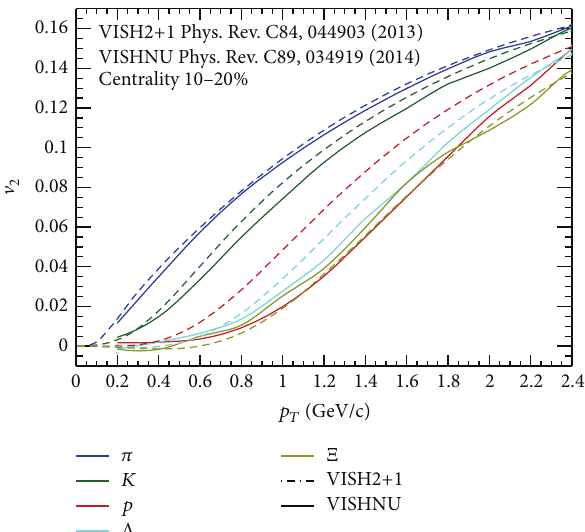
Figure 7: The viscous hydrodynamical calculations without a had- ronic cascade afterburner (VISH2+1) and with a hadronic cascade afterburner (VISHNU) [25, 37, 38, 40].